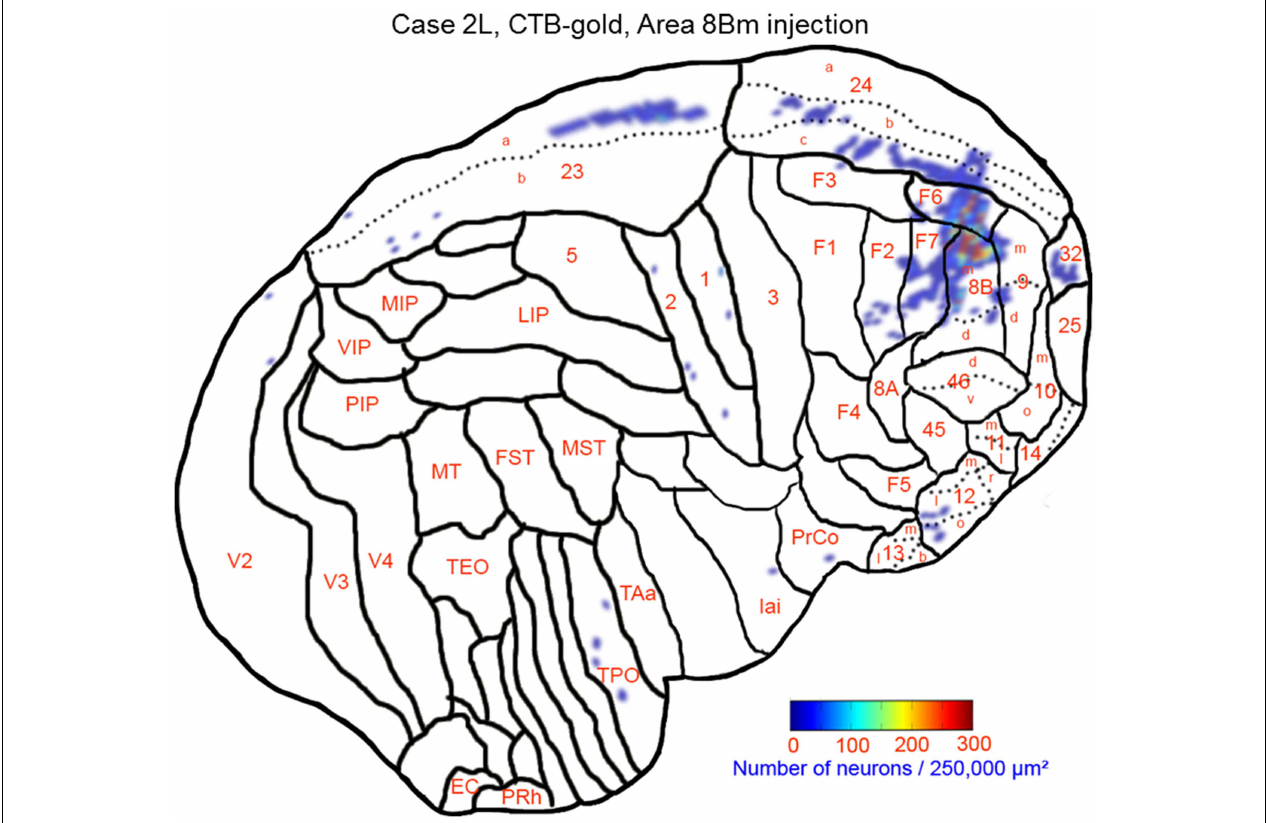
FIGURE 7 | Distribution of retrogradely labeled neurons on the flat map of the cerebral cortex in Case 2L. The density of labeled neurons was converted into a pseudo-color-code. The flat map was flipped horizontally to make the comparison between the cases easier.